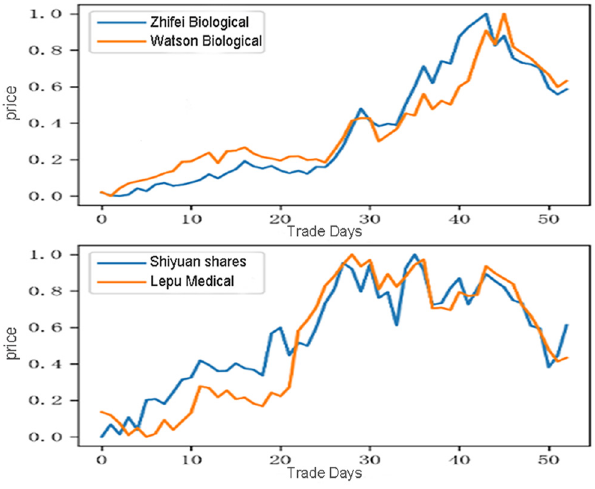
Figure 1. Stock price